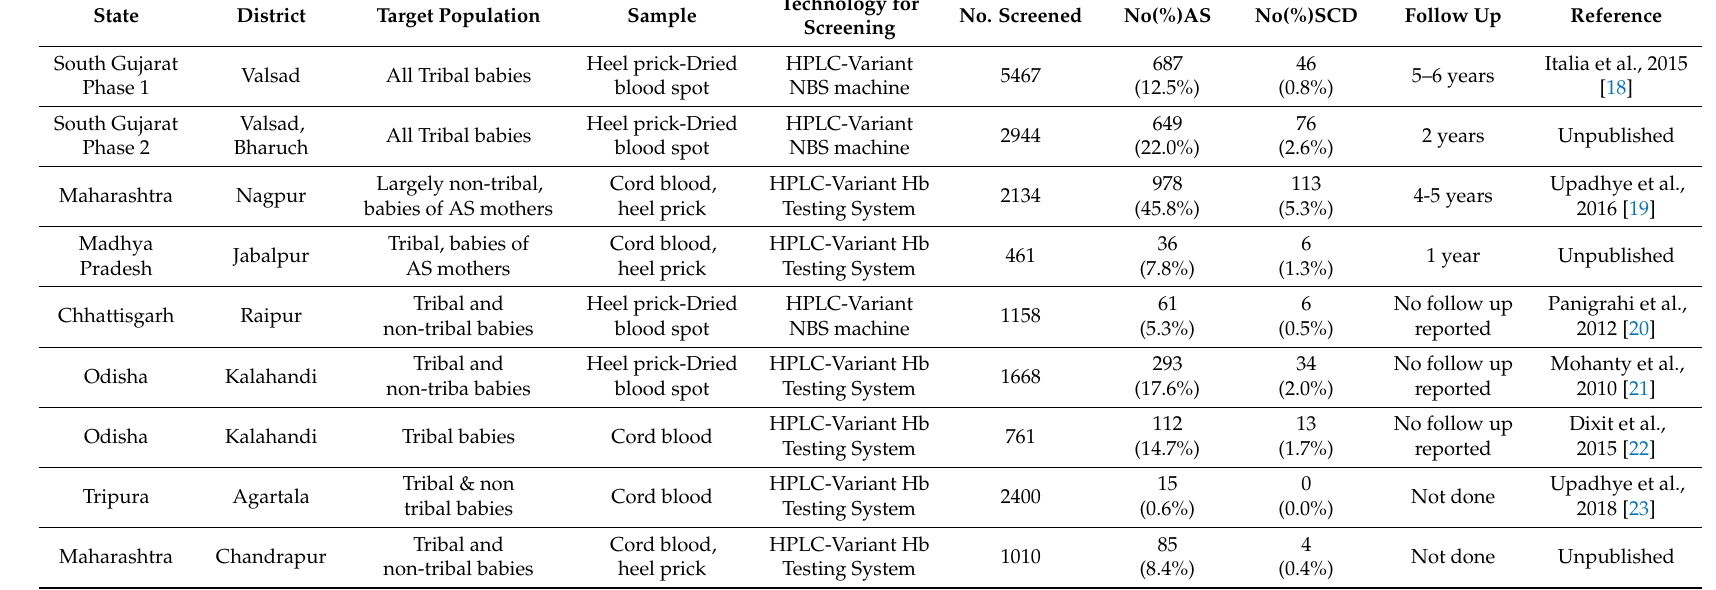
Table 1. Summary of newborn screening programs initiated in